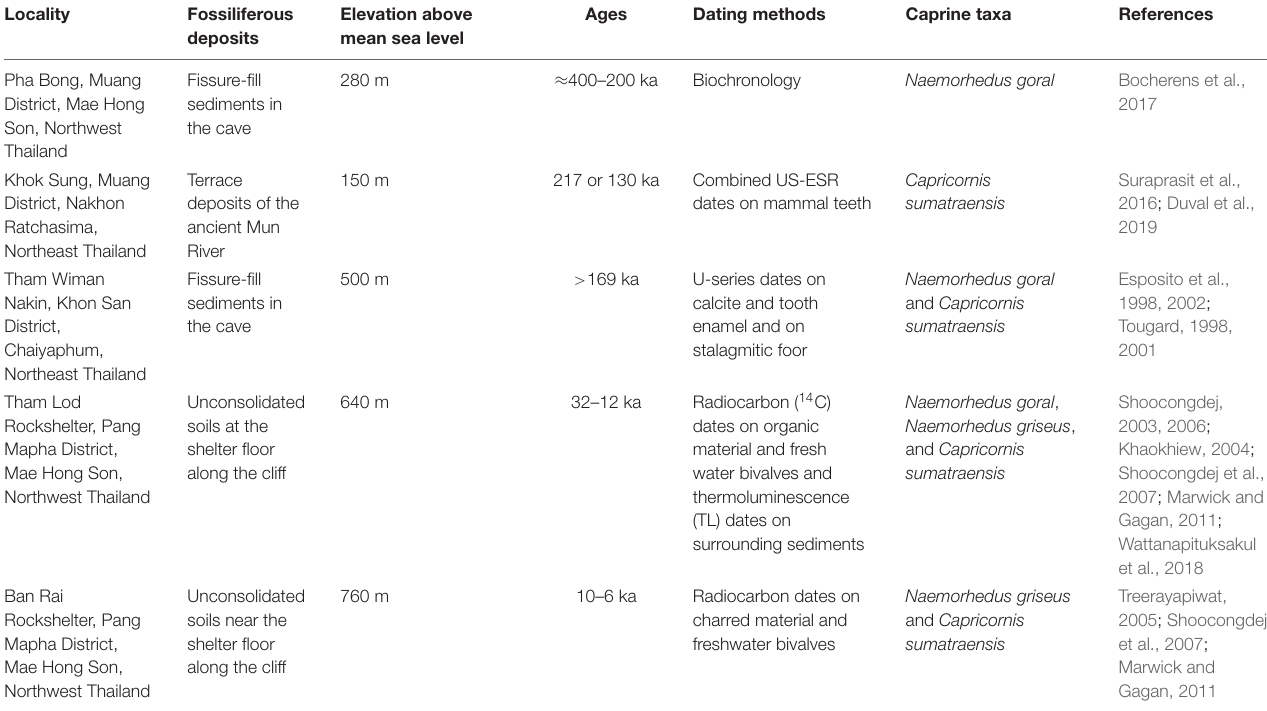
TABLE 2 | Brief information on the locations, geological settings, ages, and presence of caprine taxa of study